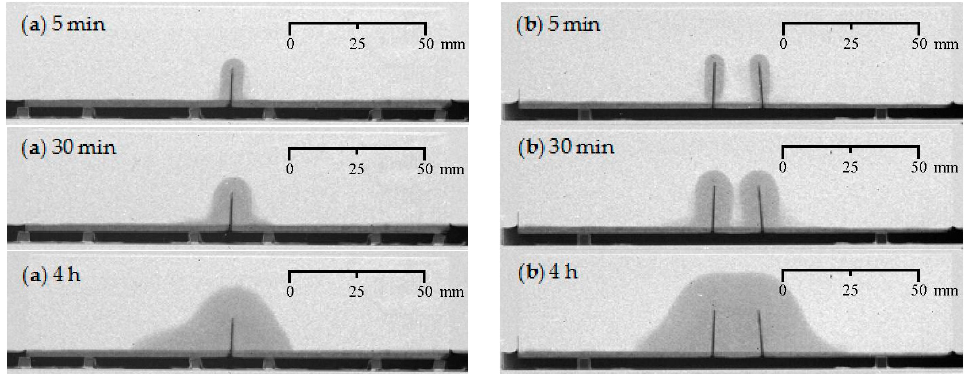
Figure 6. Visualization of the water uptake as a function of exposure time using neutron radiography for cracked mortar prisms: ( a ) one artificial crack (representative sample: CR_1_B); and ( b ) two artificial cracks (representative sample: CR_2_C).